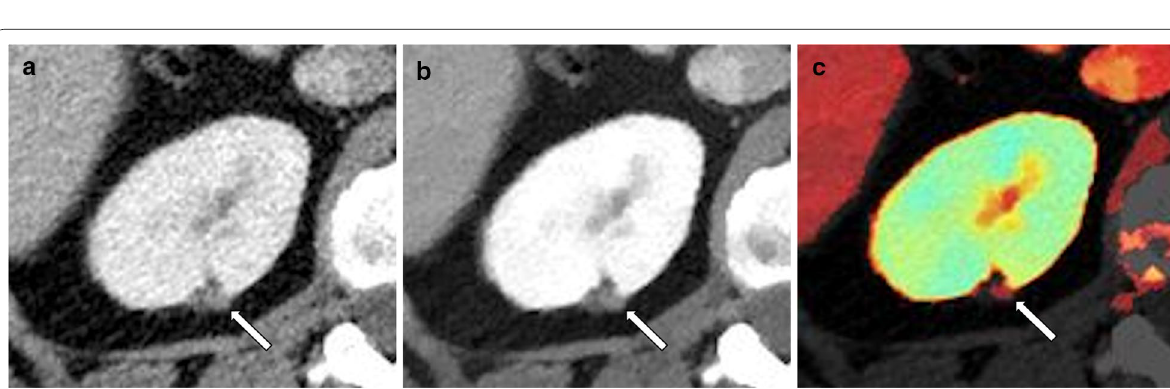
Fig. 8 A 54-year-old woman underwent a routine abdominal CT before hernioplasty. Conventional images showed an incidental finding in the right kidney (arrows) with heterogeneous attenuation on the portovenous phase ( a ). The lesion’s heterogeneity and suspected enhancing component are accentuated using a 50 keV mono-energetic image ( b ). Iodine maps prove that the lesion’s high attenuation is true enhancement ( c ), showing iodine content of 4.8 mg/mL and a normalized iodine content of 1.1 mg/mL, suspicious for